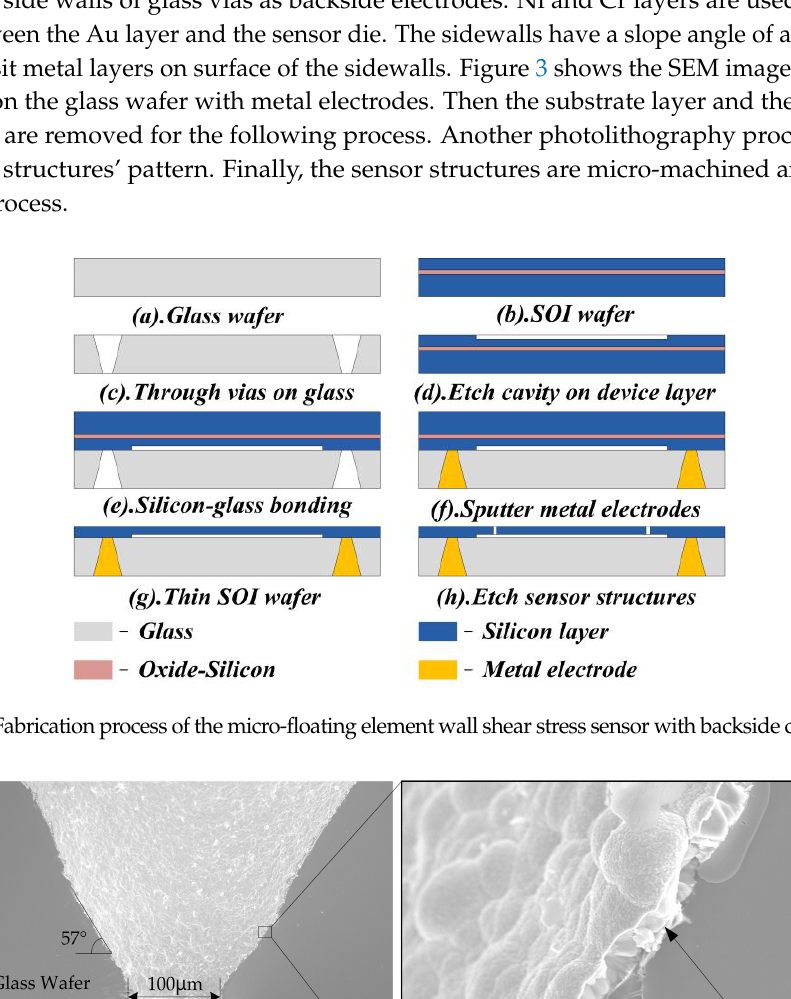
Table 1. Structural parameters of the micro-sensor in this study.